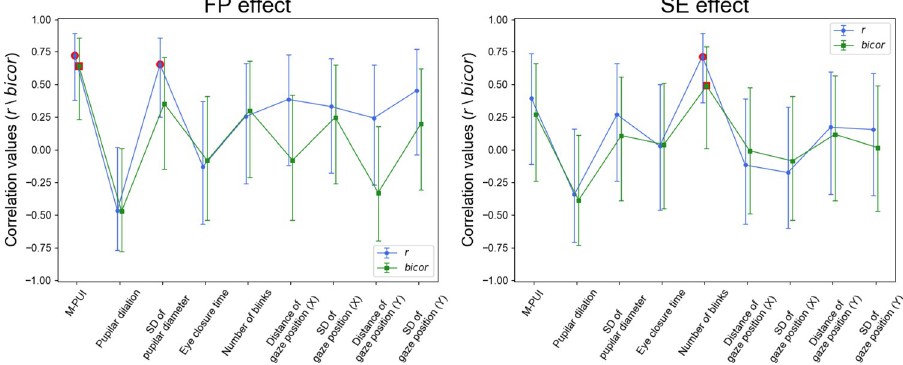
Fig 7. Correlation between FP/SE effects on RT and eye movement indices compared to M-PUI. The red circles indicate that the eye movements reached a significance level of .05. Error bars represent 95% credible